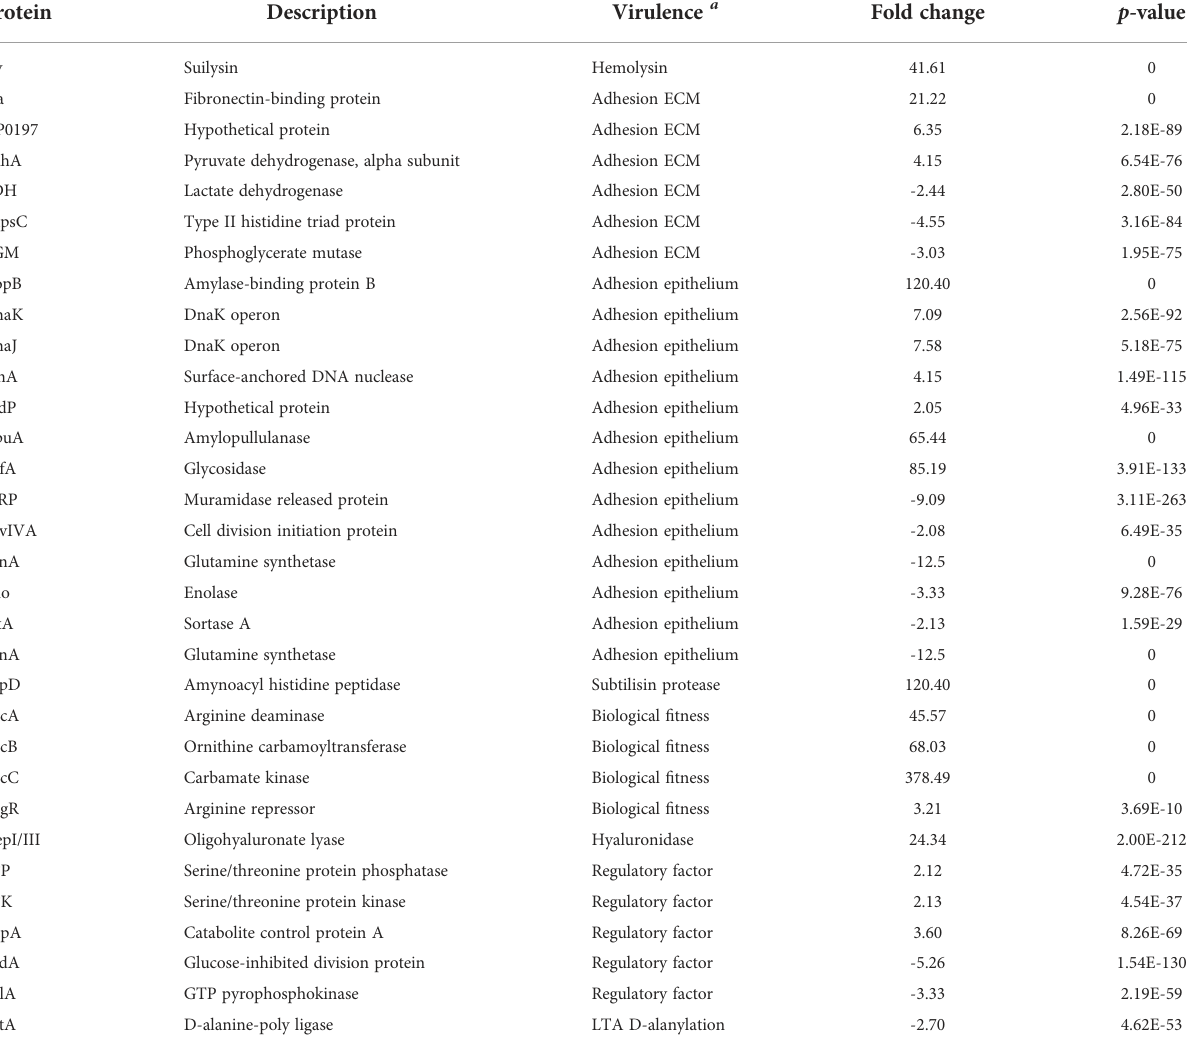
TABLE 3 Con fi rmed and putative bacterial virulence factors differentially expressed in glycogen compared with that in glucose.